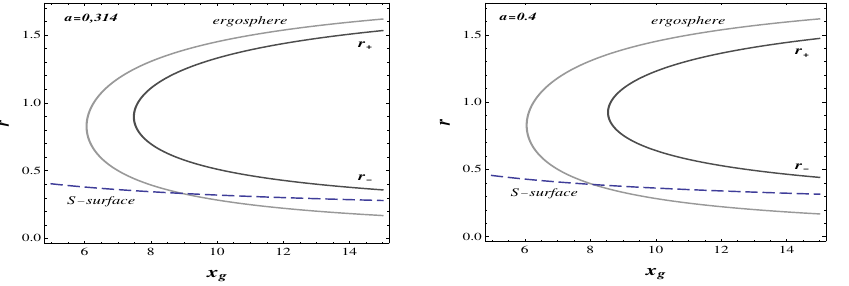
(cid:112) P ( | z | max )